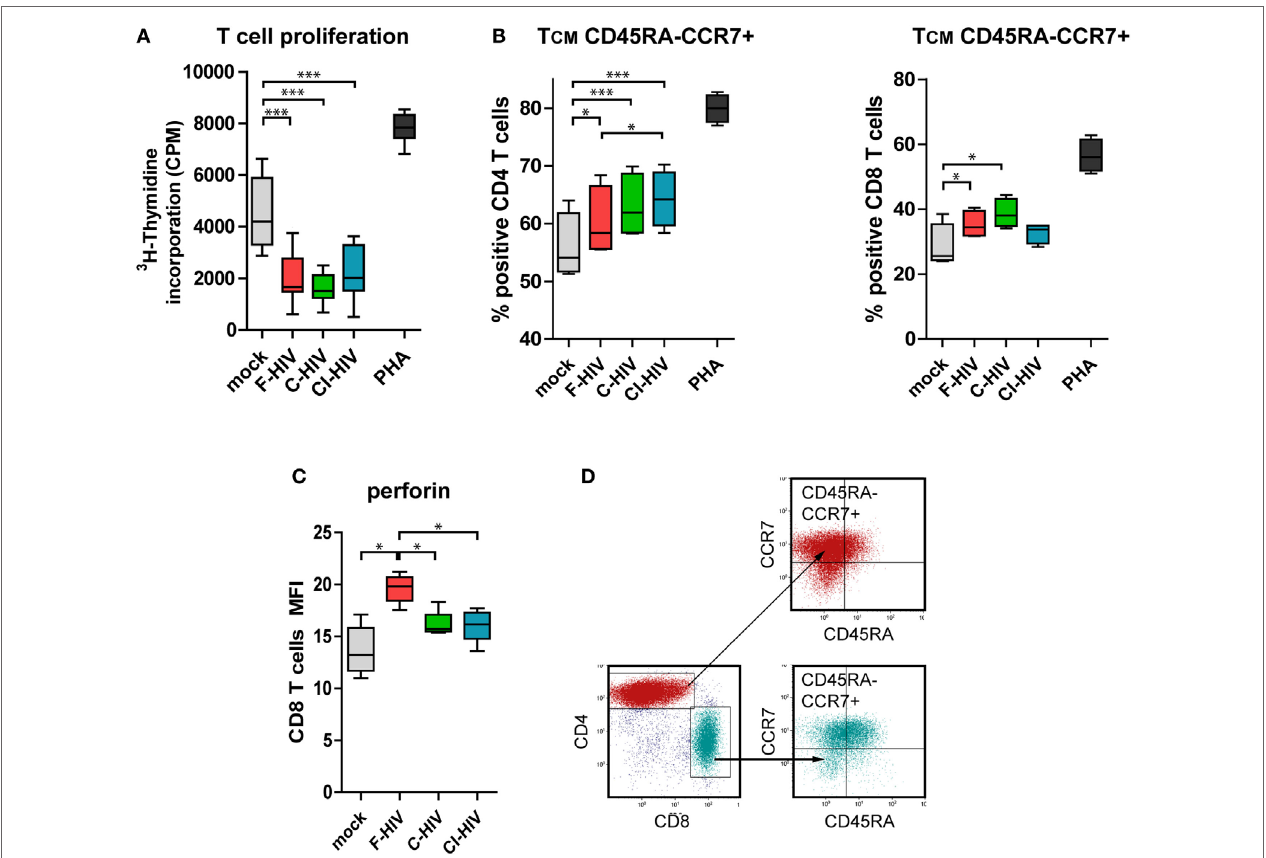
FigUre 6 | T cell proliferation and memory phenotype activated by natural killer (NK) cell–dendritic cell (DC) stimulation assay. DCs and NK cells from the same donor were exposed to 1 μ g/ml F-HIV, complement-opsonized HIV (C-HIV), complement- and antibody opsonized HIV (CI-HIV), PHA, or mock-treated for 24 h. The experiment was replicated four times using cells derived from four different donors. Allogeneic T cells were stimulated by cells from these cultures at a 1:10 DC:T cell ratio. (a) T cell proliferation was assessed using a 3 H-Thymidine incorporation assay. (B) Supernatants from the NK–DC cross talk cultures were added to allogeneic T cells stimulated by CD3/CD28 ligation and the percentage of cells with central memory (T CM ) phenotype in the CD4 and CD8 T cell populations was determined using flow cytometry. (c) The amount of perforin in the CD8 T cells from the NK–DC stimulation assay was evaluated. (D) Gating strategy for flow cytometry analysis of a representative sample can be seen in. Boxplots show mean with Tukey error bars. One-way ANOVA followed by a Bonferroni posttest was used to test for statistical significance (* p < 0.05, N = 4).